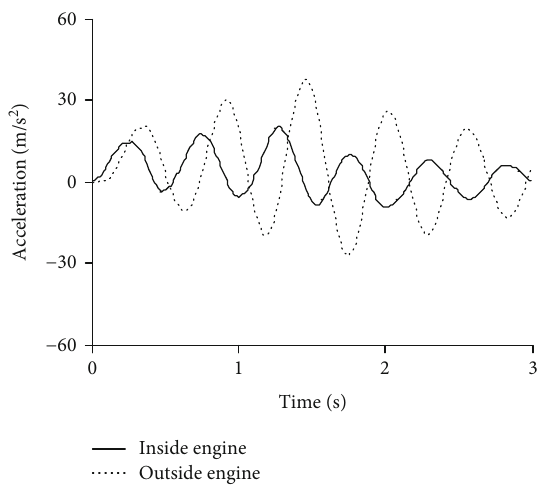
Figure 11: Transient response of acceleration at typical sections of fuselage under repeated waves.